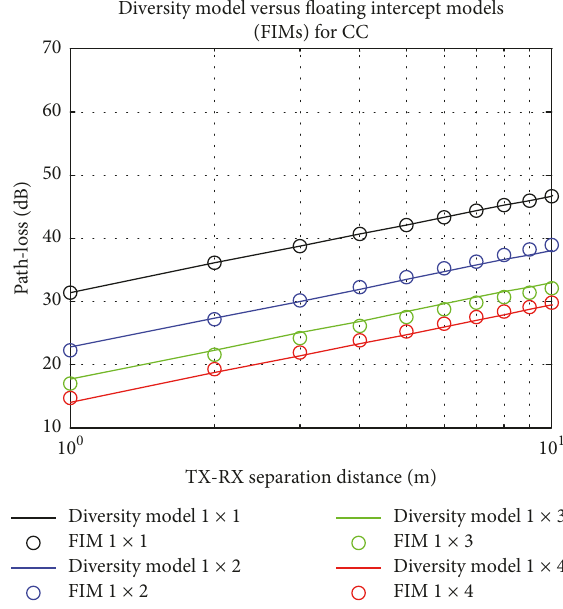
Figure 17: Path-loss for the proposed floating intercept-based diversity model given by (6) for the NCC scheme when considering LOS scenario, with 𝛼 SISO = 24.75 , 𝛽 SISO = 1.54 , and 𝐵 = 0.189 .